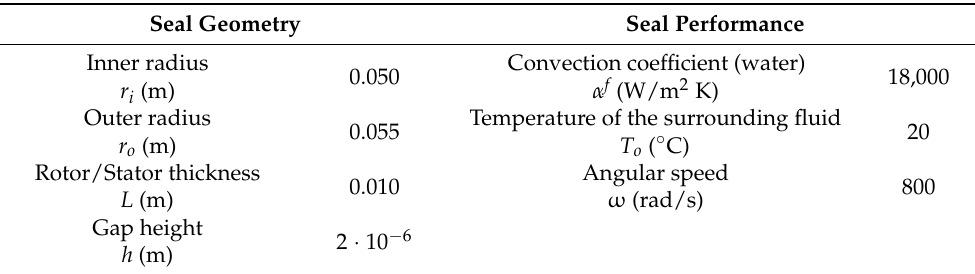
Table 2. Parameters related to seal geometry and